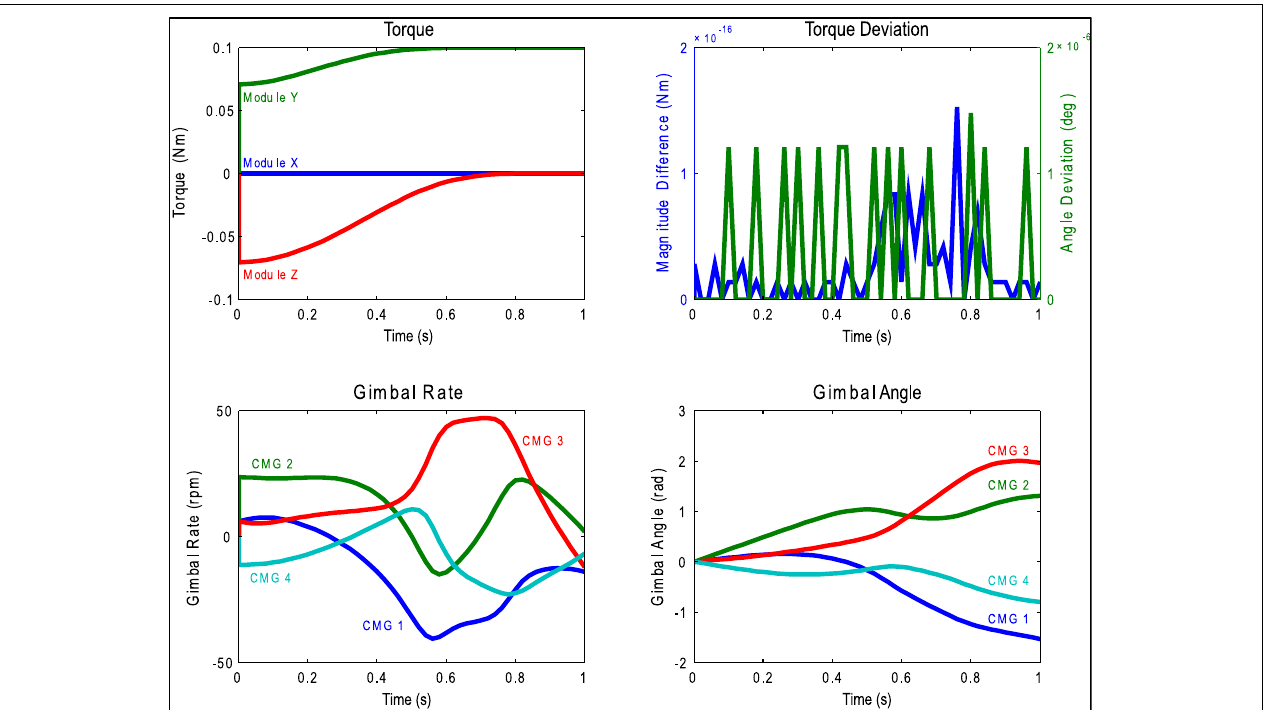
FIGURE 6 | Results from the four CMG pyramid simulation with the 90-90-90 motion for an array with steel flywheels of radius 2cm and height 1cm.